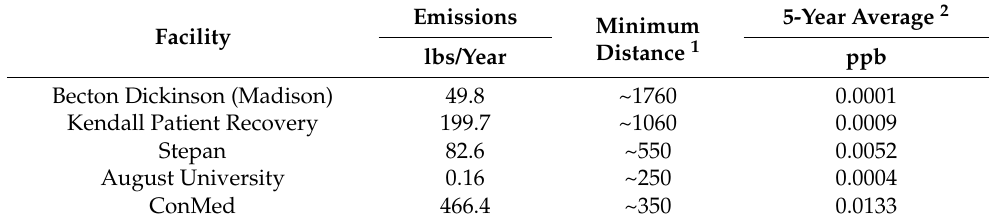
Table 6. Modeled residential ambient air EO concentrations for the additional sterilization, manufacturing, and warehouse facilities in Georgia without corresponding ambient EO monitoring